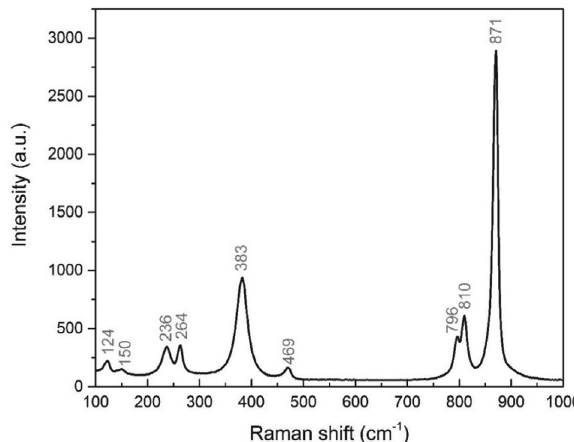
Fig. 3. SEM images of the NdVO 4 nanopowders. (a) Low magnifica- tion, (b) High magnification.